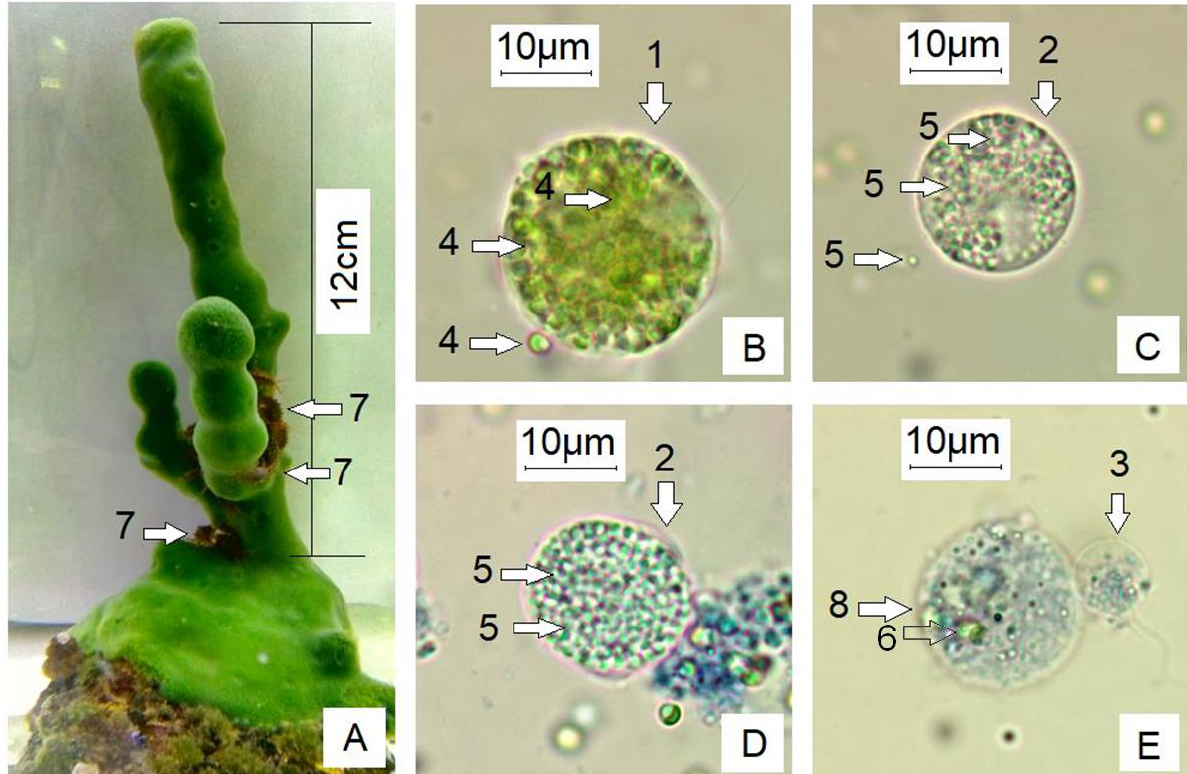
Figure 2. Photo of Lubomirskia Baikalensis (class Demospongiae, order Spongillida, family Lubomirskiidae) in aquarium and the sponge dominant cell light microscope images. ( A ) – underwater image of epilithic sponge with exosymbionts (7) Brandtia parasitica (class malacostraca, order Amphipoda, family Acanthogammaridae); ( B ) – healthy sponge amoebocytes of the first type (SA1-cells) (1) and its eukaryotic endosymbionts Chlorella sp. (4); ( C ) — healthy amoebocytes of the second type (SA2-cells) (2) and its prokaryotic endosymbionts; (5); ( D ) – healthy amoebocytes (SA2-cells) (2) and its prokaryotic endosymbionts (5), stained with methylene blue; ( E ) – amoebocytes containing symbiont assemblage (SA3-cells) (8) including green algae (6) and a cell with flagellum (SA4-cell) containing prokaryotic symbionts (3).